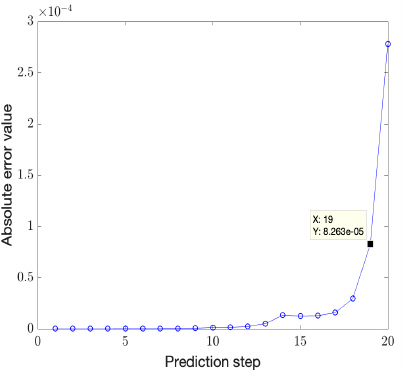
Figure 9. One-dimensional logistic error iterative convergence curve. The blue line represents the absolute error value curve, and the blue circle represents the absolute error value.